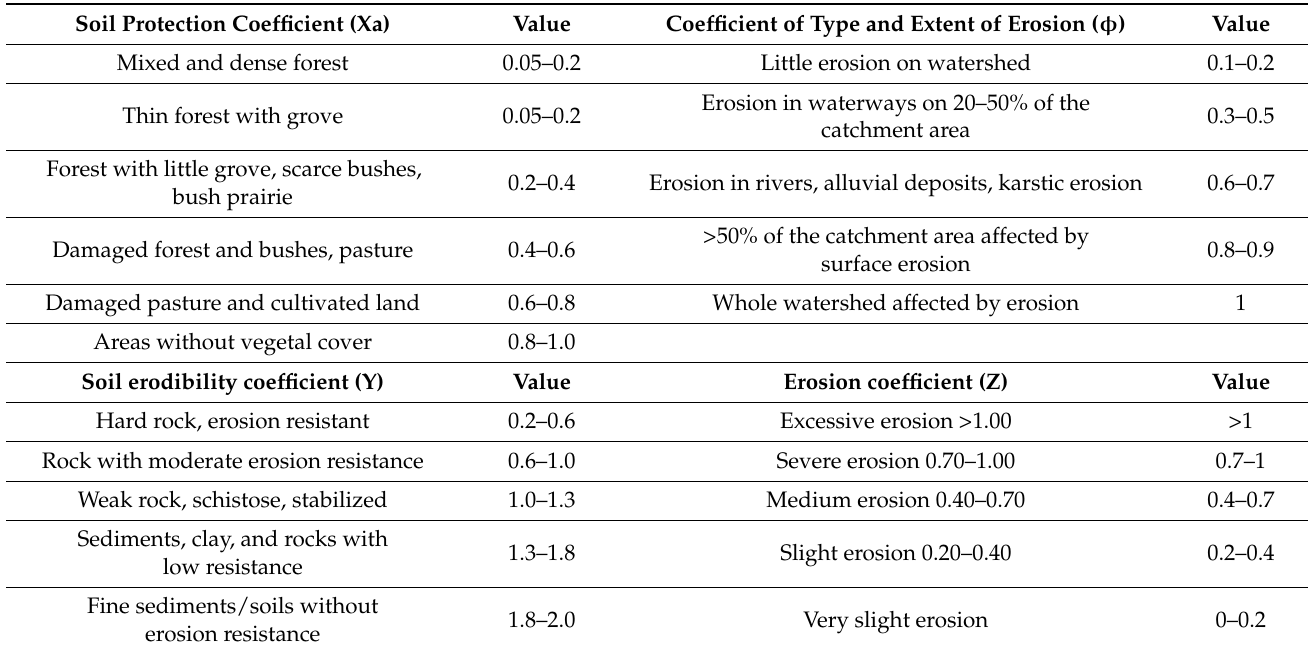
Table 1. A descriptive evaluation of the EPM model parameters